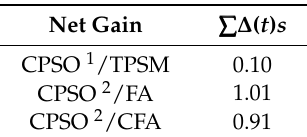
Table 12. Comparison of the total net gain in time achieved by the proposed algorithm compared with the literature for Case III.